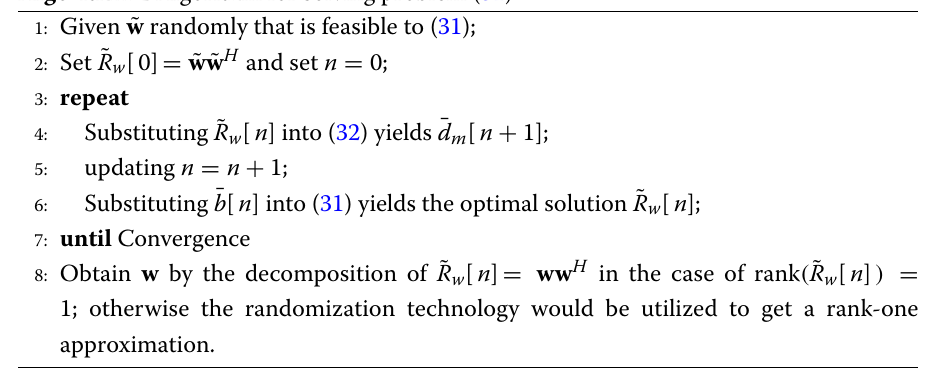
Algorithm 2 Algorithm for solving problem